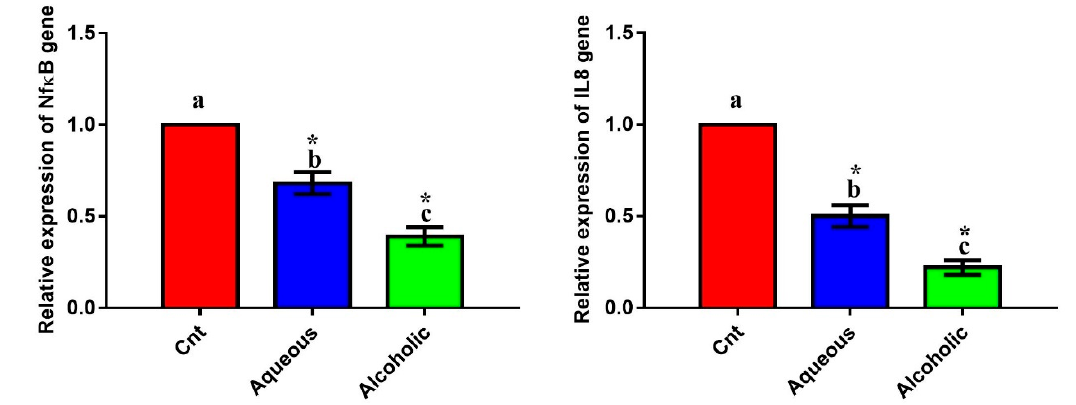
Figure 8. Expression of NF κ B and IL8 genes in MCF7 cells following treatment with 5% larval aqueous and alcoholic extracts. Data are expressed as the mean ± SEM. Samples were run in triplicate in three independent experiments, n = 5. Groups with different letters are significantly different at p < 0.05. * indicates high significance with respect to the control ( p < 0.01).